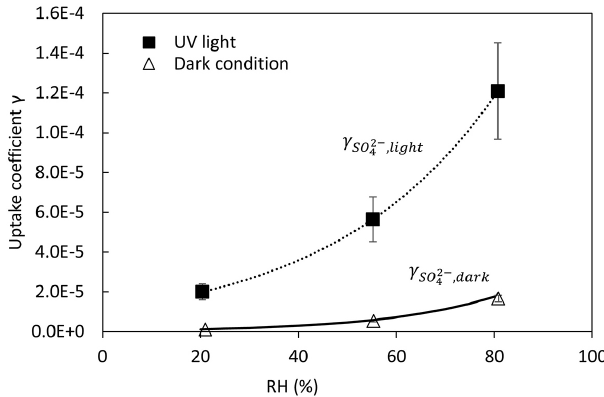
Figure 2. Uptake coefficient ( γ) of SO 2 in the presence of the ATD particles under dark conditions and UV light conditions. The val- ues of γ were obtained by kinetic model using indoor experimental data. The γ is correlated to concentration of OH radicals SO 2 − 4 , light and RH (%). The γ is a function of RH. The error bar of γ SO 2 − 4 , dark was derived from the model